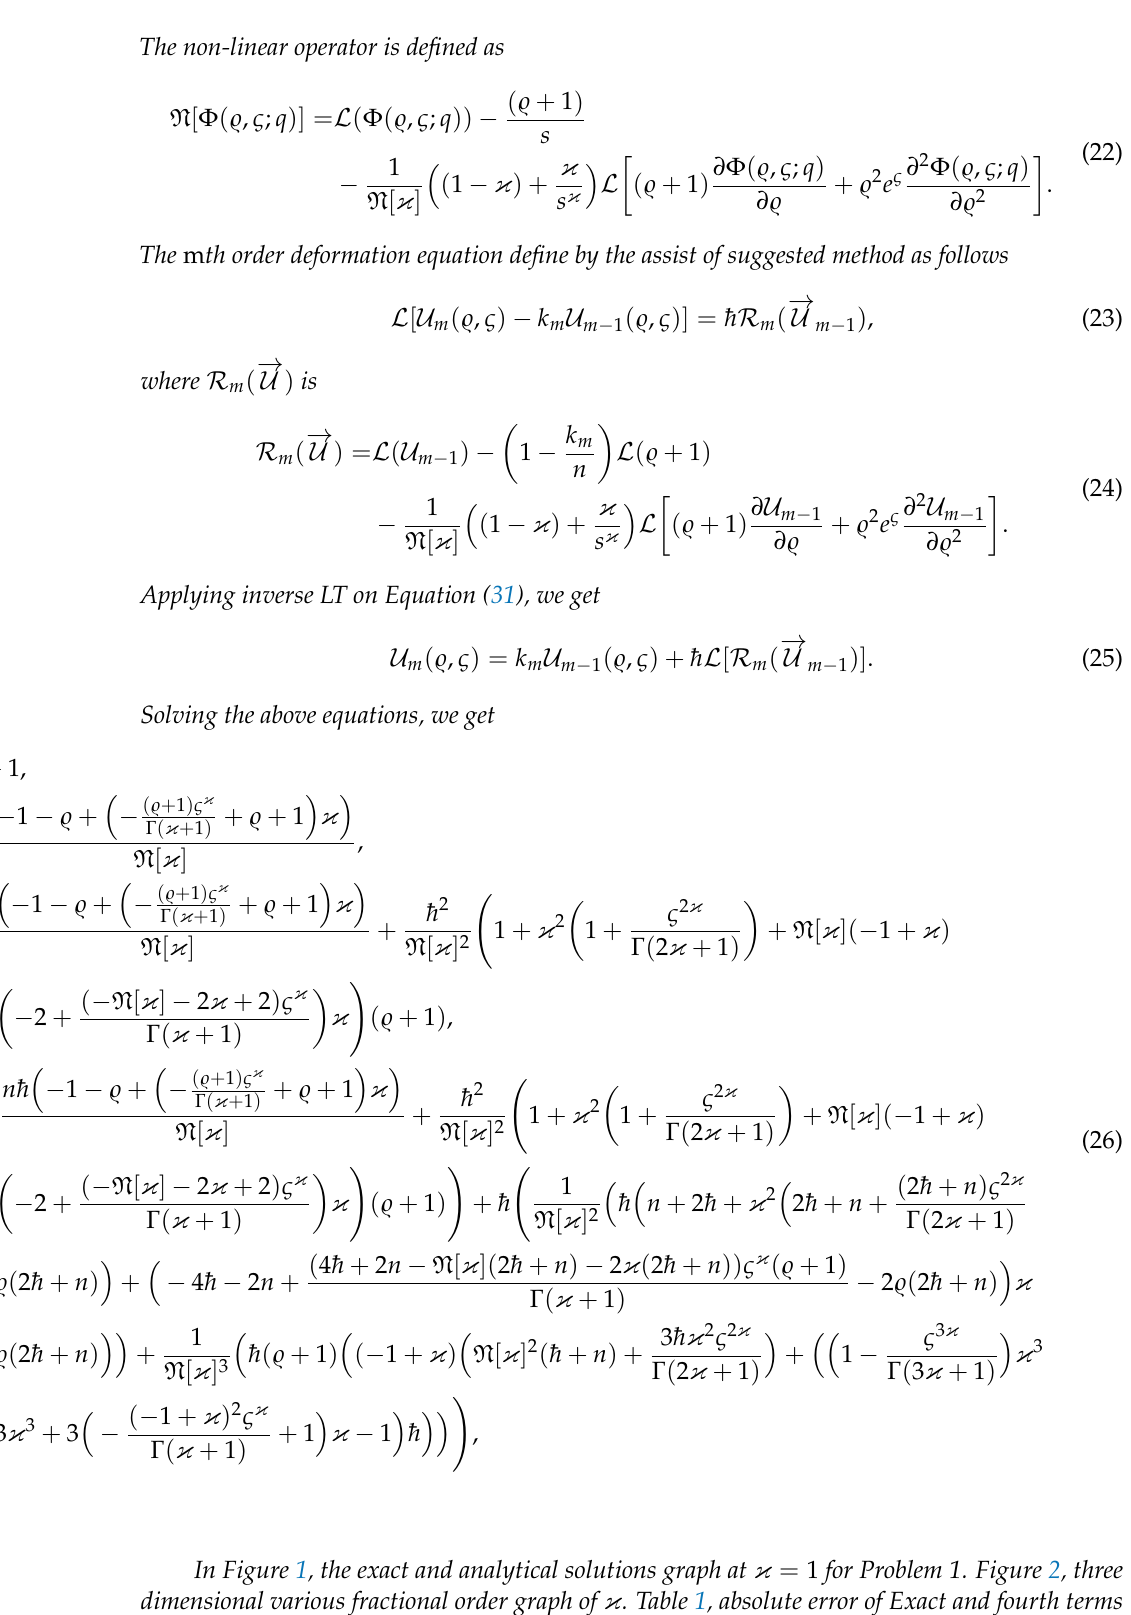
approximate solutions for Problem 1 with various ς and (cid:36) for κ = 1